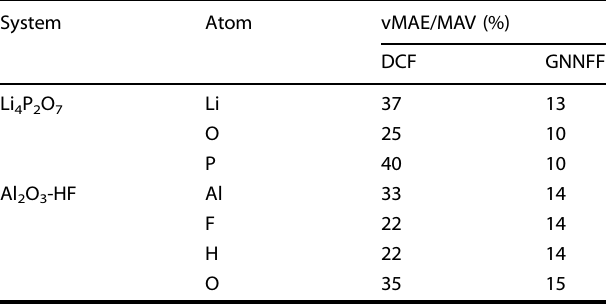
Accuracy is measured separately for each element in terms of vMAE/MAV, where lower values indicate higher accuracies. For both systems, GNNFF accuracy for each element is higher than that of DCF.